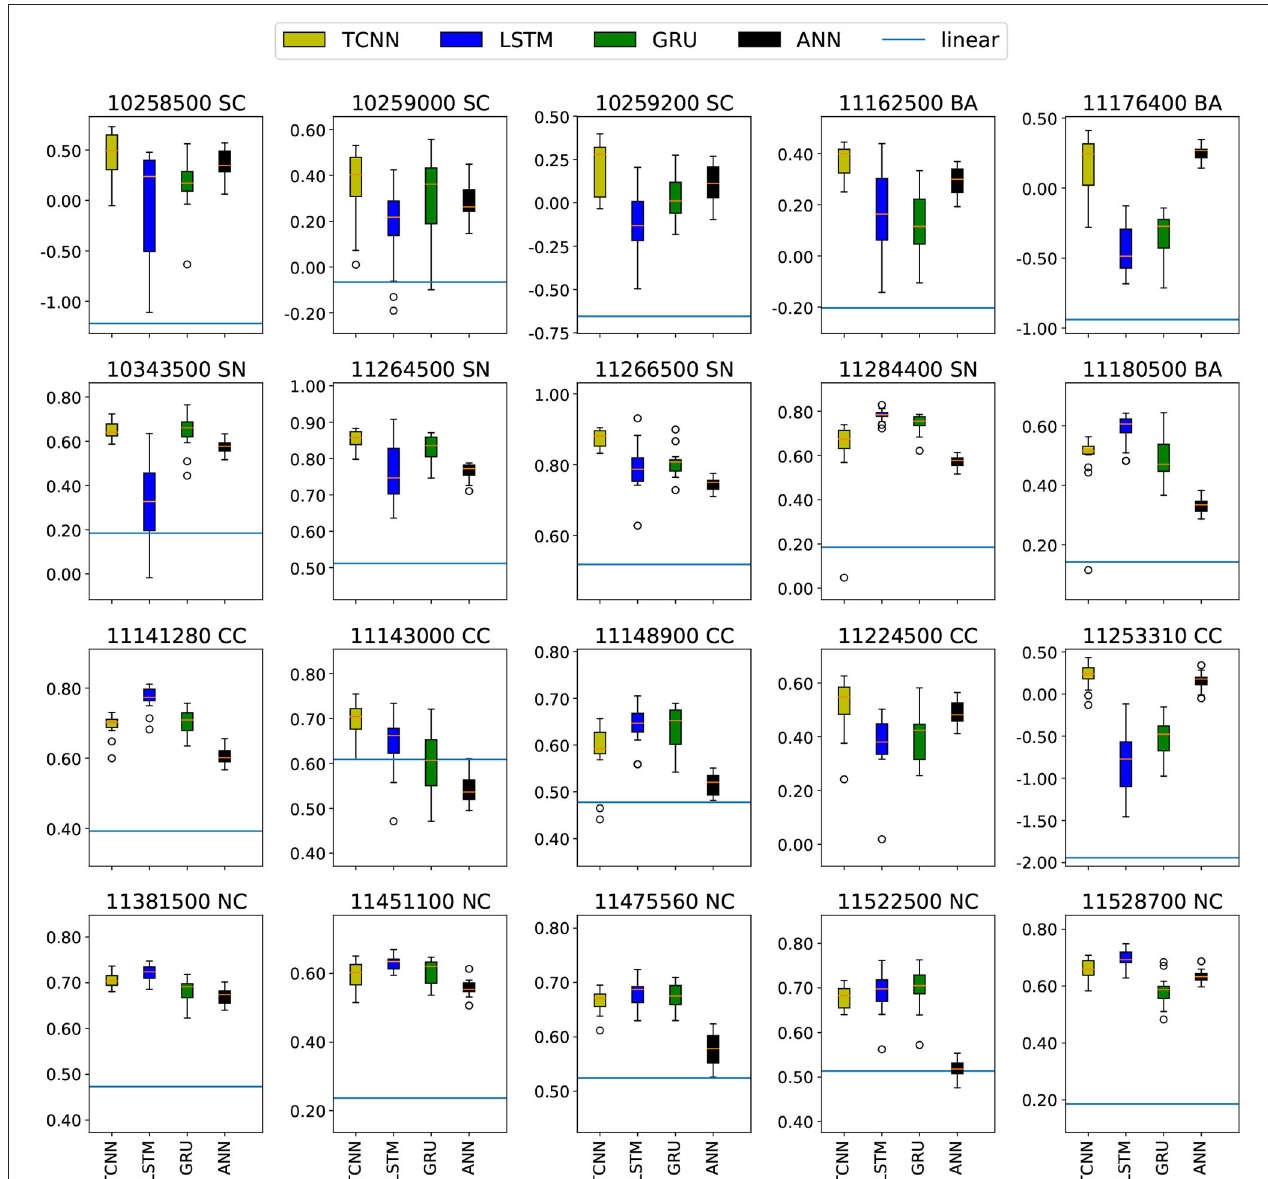
FIGURE 2 | Ensemble prediction comparison for all basins with different models. The boxplots denote results over each ensemble of 15 model runs for the ML models. The straight line denotes the linear regression result. For basin 11224500 CC the linear regression model produced a NSE of − 2.47.